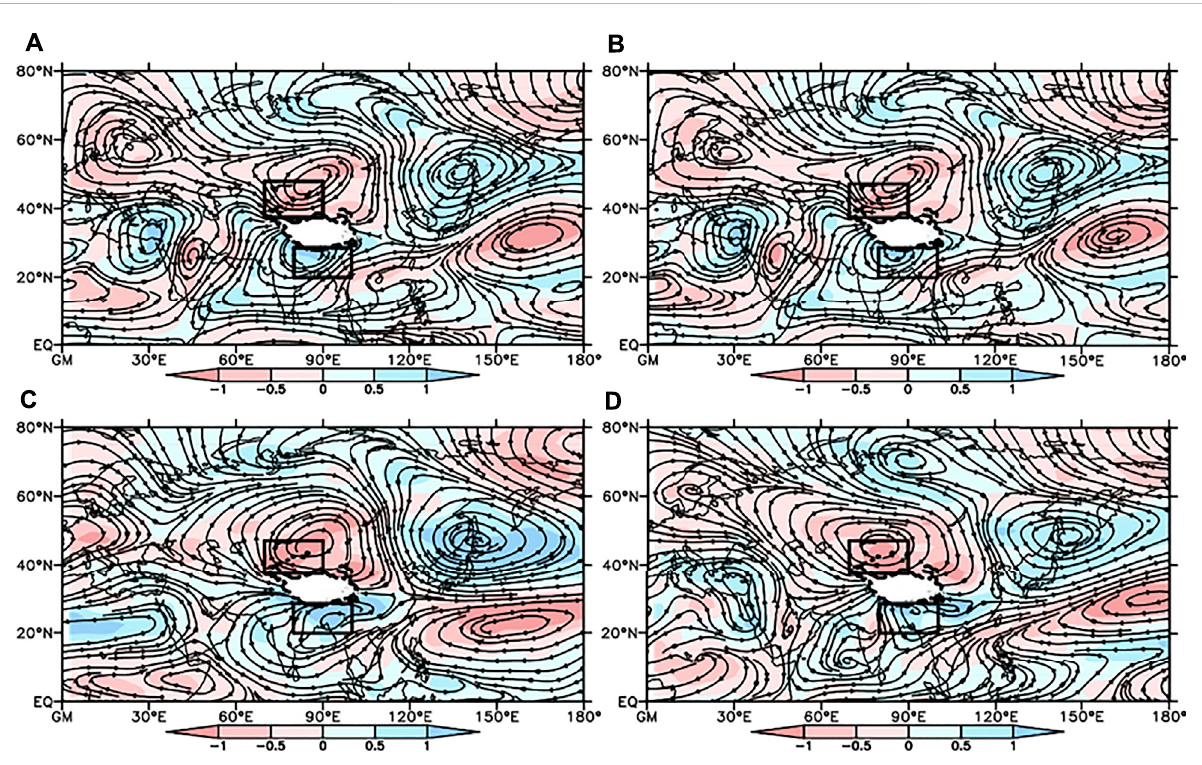
FIGURE 1 The mean zonal deviation circulation (unit: m s − 1 ; contours) and vorticity (unit: 10 − 5 s − 1 ; shaded) fi eld in (A) winter half-year, (B) autumn, (C) winter, (D) spring at 600 hPa. The boxes to the north and south of the TP represent the average positions of northern branch ridge and southern branch trough,